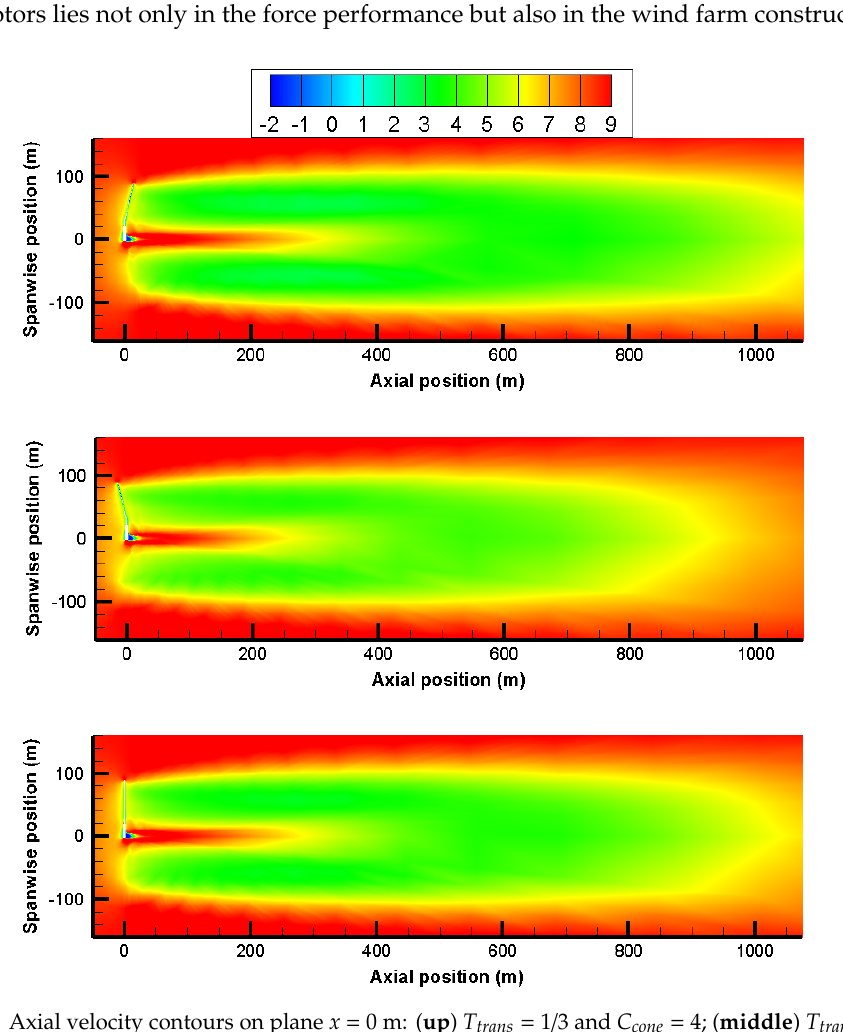
Figure 8. Axial velocity contours on plane x = 0 m: (up) T trans = 1/3 and C cone = 4; (middle) T trans = 1/3 and and C cone = − 4; ( down ) straight C cone = − 4; (down) straight rotor.